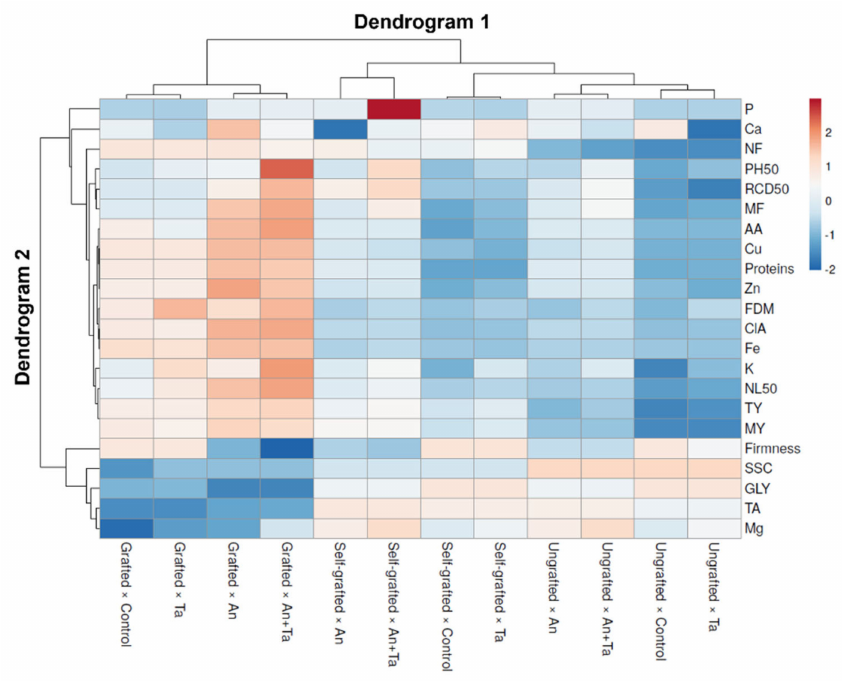
Figure 3. Heat map analysis including all eggplant plant features in response to grafting and biostimulant application. The heat map was realized via the https://biit.cs.ut.ee/clustvis/ (accessed on 1 March 2022) online program package. An: Ascophyllum nodosum ; Ta: Trichoderma atroviride